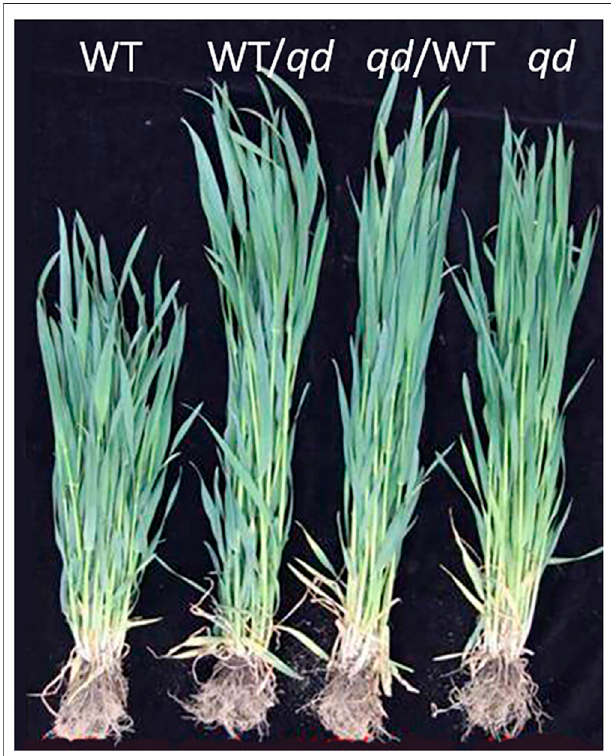
FIGURE 4 | Δ SNP index values of all SNPs across the chromosomes. Note: The colored dots represent the SNP index values for this region. The black line represents the fi tted SNP index value. The green, blue, and red lines represent the threshold lines with con fi dence levels of 0.90, 0.95, and 0.99, respectively.